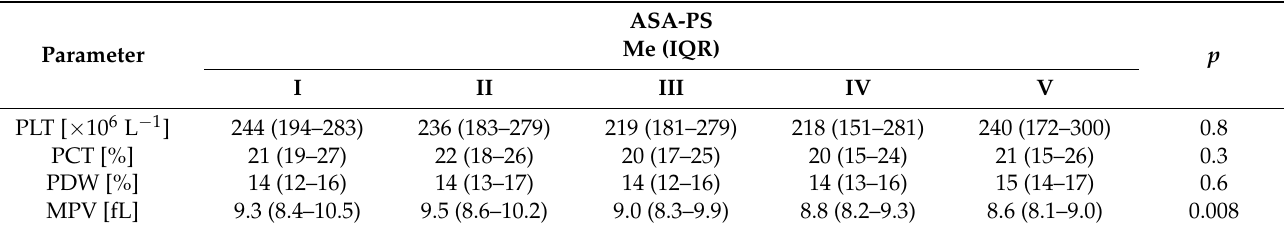
Table 4. Platelet parameter values and ASA-PS classification.